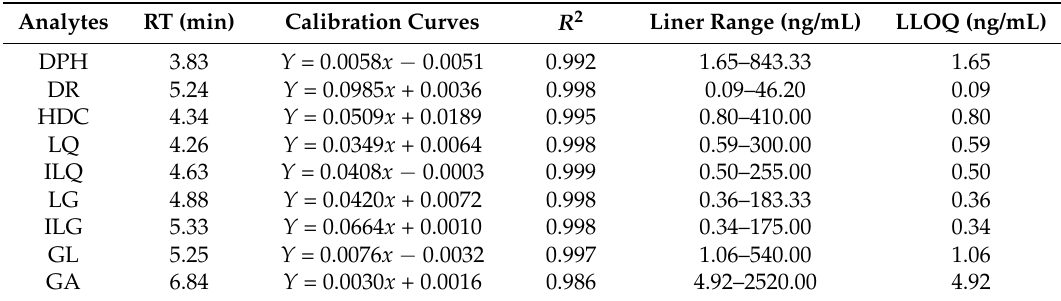
Table 1. Calibration curves, linear ranges, correlation coefficients ( R 2 ) and LLOQ of DPH, DR, HDC,